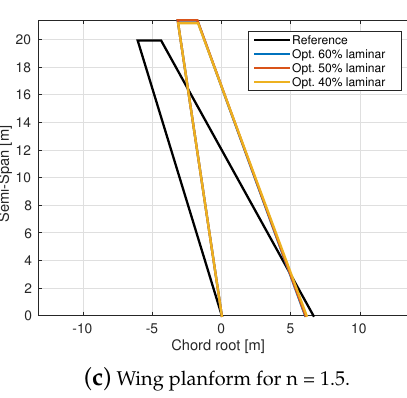
Figure 14. Forward-swept wing geometry at different load factor and portion of laminar